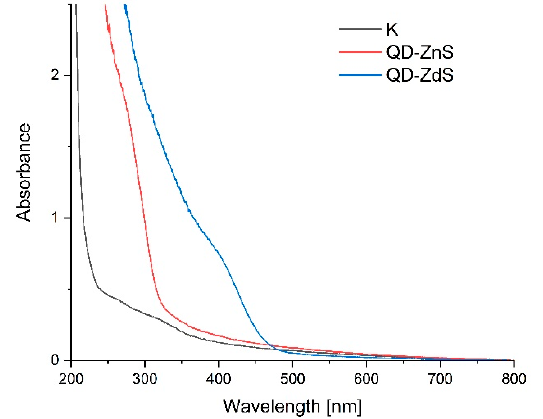
Figure 5. UV ‐ VIS spectra of the control film (K), ZnS quantum dot film (QD ‐ ZnS), and CdS quantum Figure 5. UV-VIS spectra of the control film (K), ZnS quantum dot film (QD-ZnS), and CdS quantum dot film (QD ‐ CdS). dot film